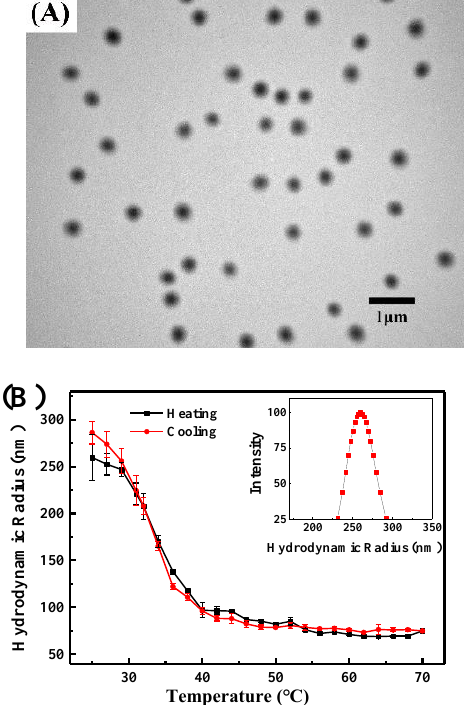
Figure 1. ( A ) Representative TEM image of SSZ-MGs and ( B ) hydrodynamic radius of SSZ-MGs in aqueous suspensions as a function of temperature measured by DLS. The inset of ( B ) showed the size distribution of SSZ-MGs in aqueous suspensions at 25 ◦